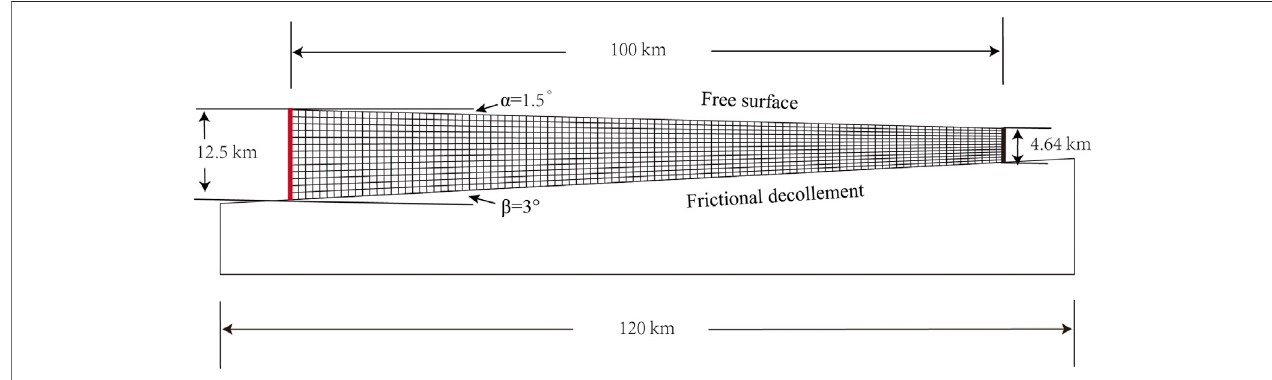
FIGURE3| Modelsetting:initialconditionforgeometryandgridde fi nitionusedinmodelingtectonicsofJiudongBasinregion.Leftend(SW)ismarkedbyaredline and is movable; right end (NE) is marked by a black line and is fi xed. These particular parameter values pertain to our reference model.